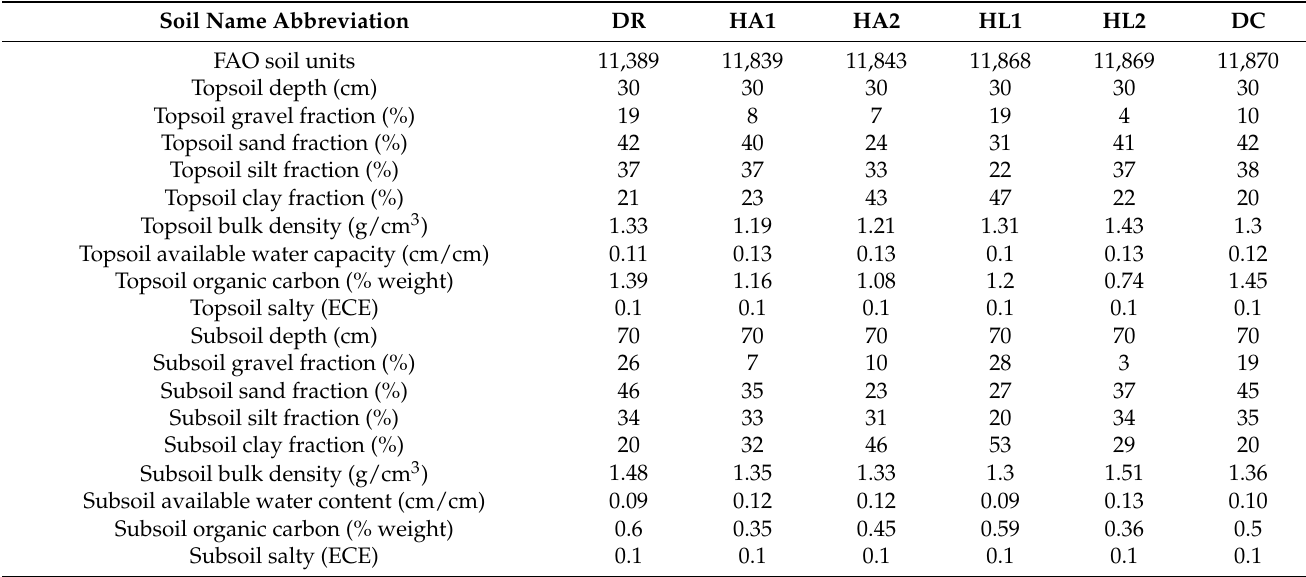
Table 2. Physical properties of six soil types in the Daotian River